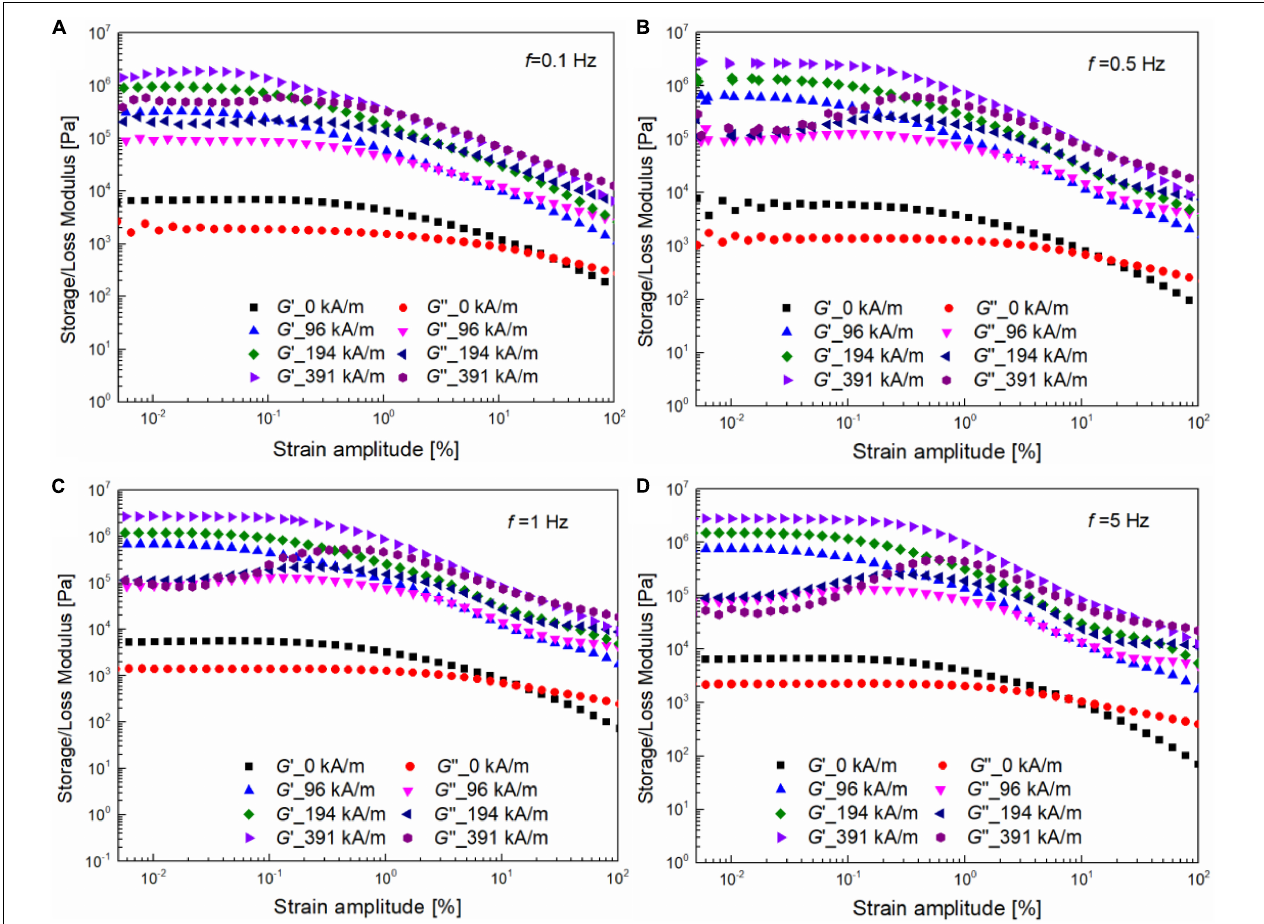
FIGURE 2 | Oscillatory strain sweeps were conducted under different magnetic fields, i.e., 0, 96, 194, and 391 kA/m, at the fixed frequencies of (A) 0.1, (B) 0.5, (C) 1, and (D) 5 Hz.